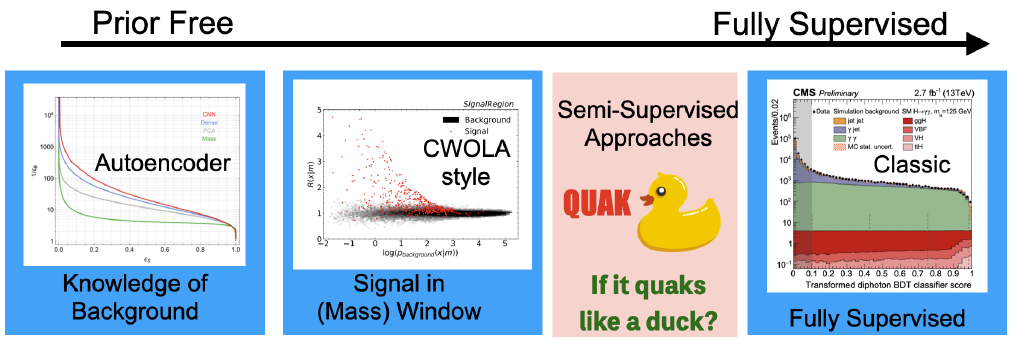
Figure 1 . Overview of Deep Learning based methods used in high energy physics. The prior here indicates the amount of a signal prior used within the search. This paper presents QUAK, which falls into a region labeled by the red shaded